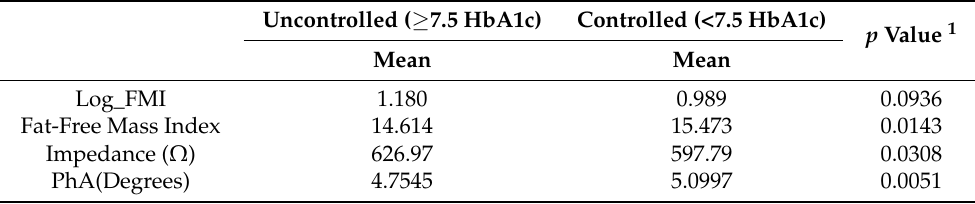
Figure 2. Correlation between Phase Angle and Glycated Haemoglobin. Table 6. Shows the differences in body composition by glycaemic Body composition parameters in relation to the level of glycaemic control are sum- marised in Table 6.